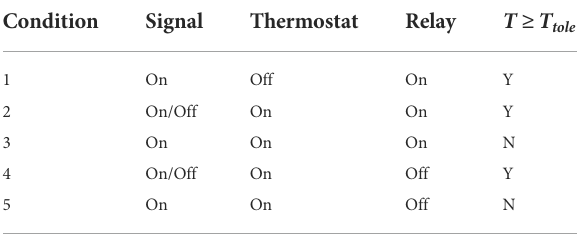
TABLE 1 Available control